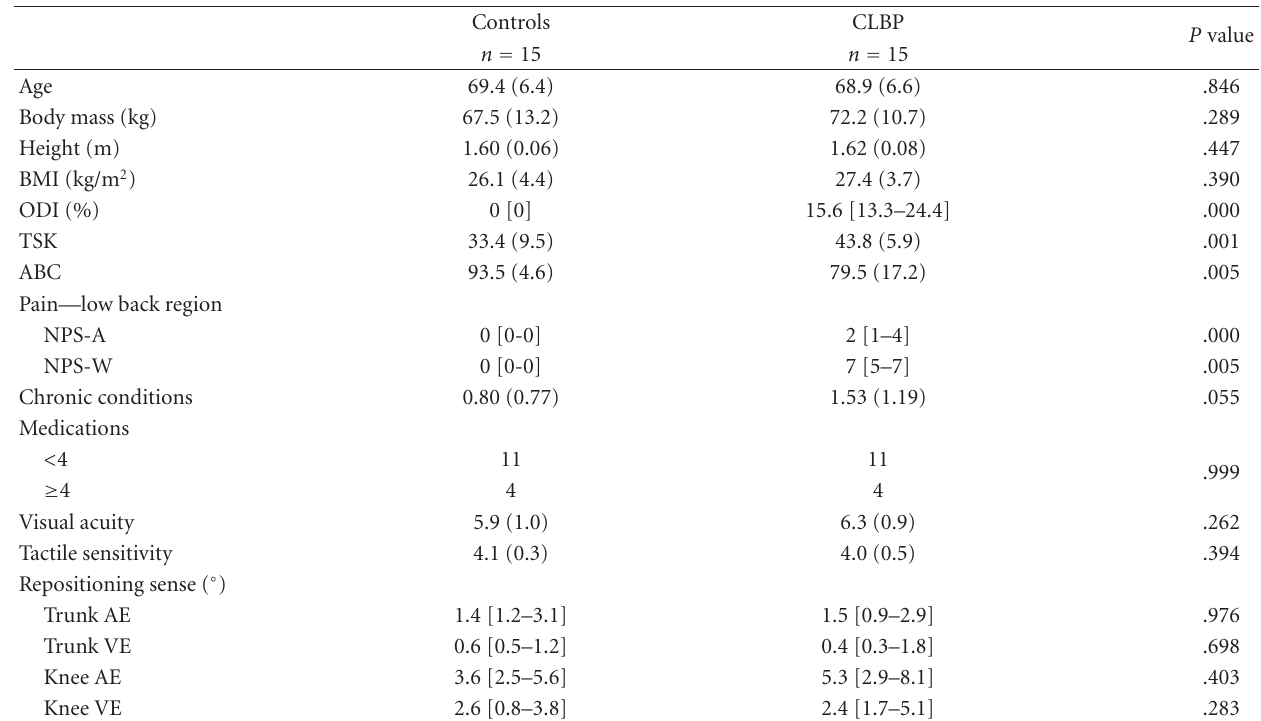
Table 1: Subject